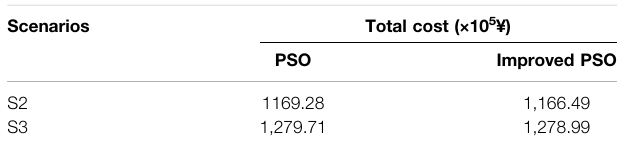
TABLE 5 | Comparison of solution results.